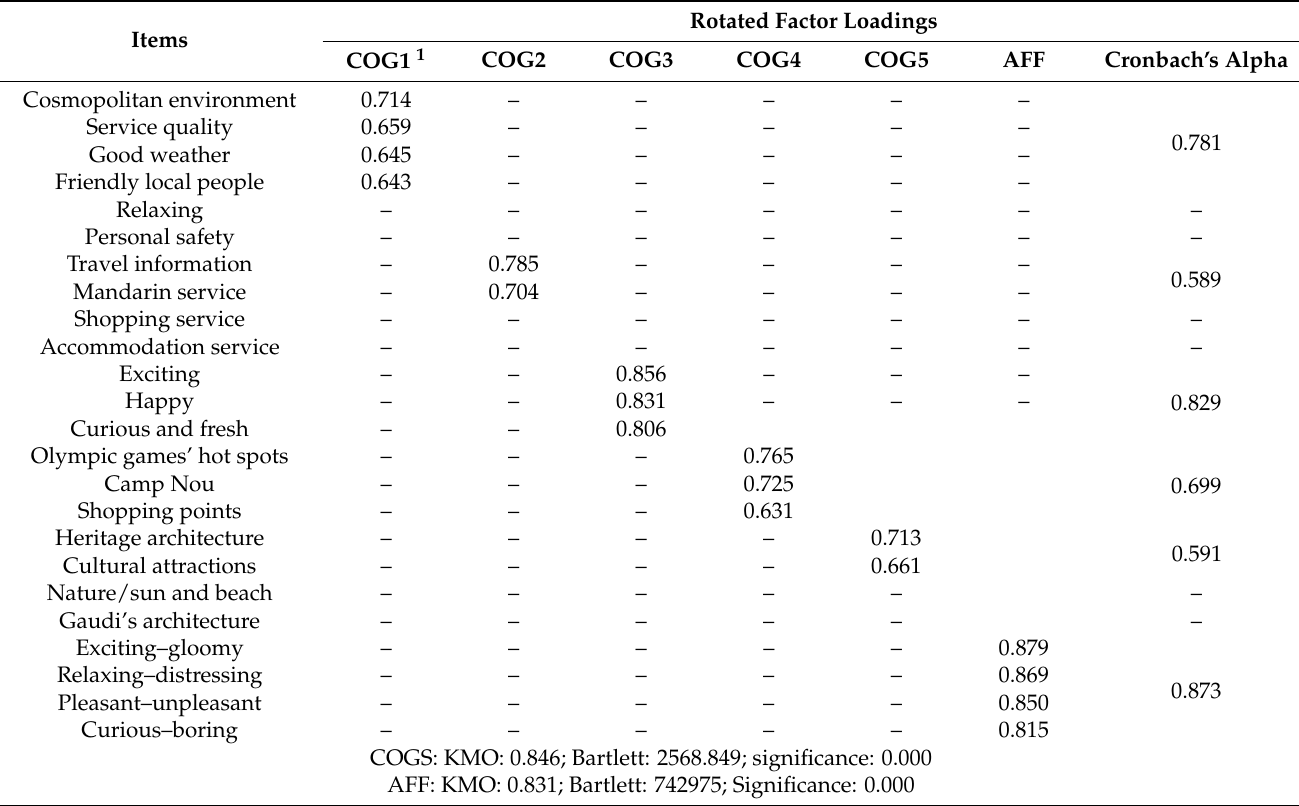
Table 3. Principal component analysis of cognitive and affective